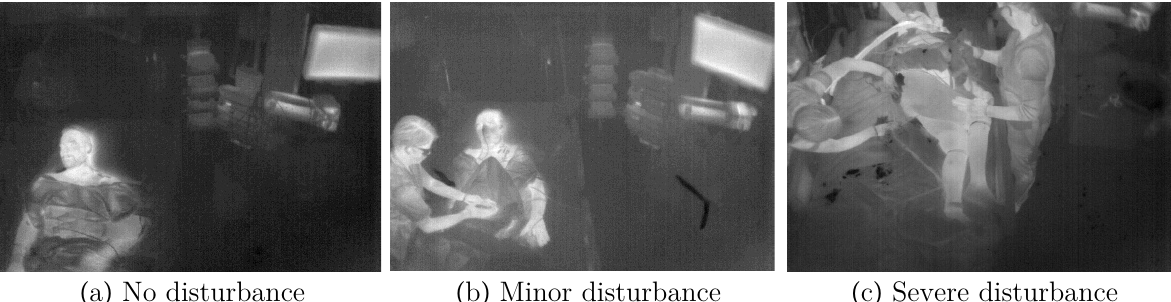
Figure 9. Different levels of disturbances in IRT